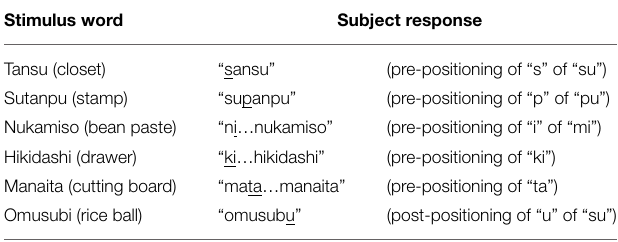
TABLE 1 | Examples of sequential